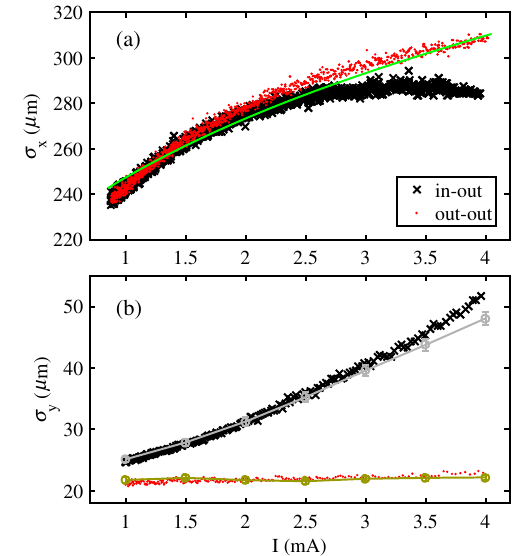
FIG. 6. Beam sizes as a function of the beam current for the e − lattice lat − ð 0 Þ . The red dots are the data measured with both scrapers retracted and the black crosses are the data with top scraper fully inserted. Circles are from tracking simulations. The green line is calculated beam size growth due to IBS with both scrapers retracted.